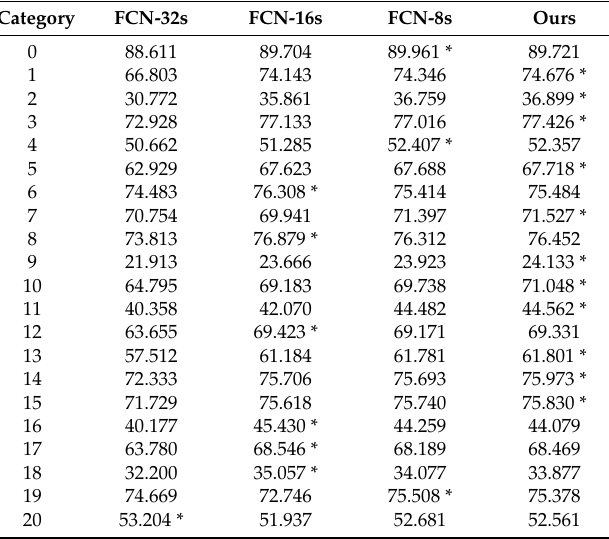
Table 3. The IoU scores of four